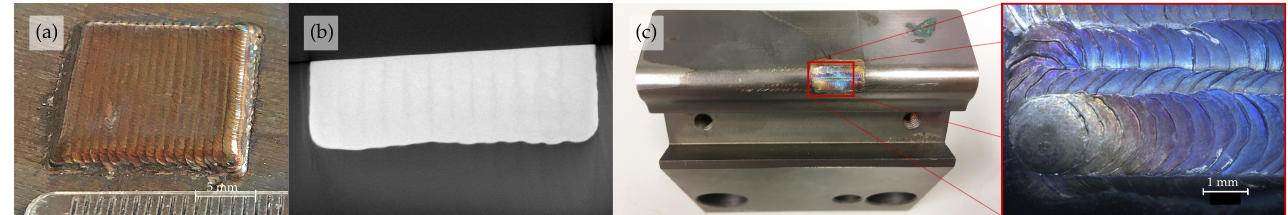
Figure 8. ( a ) 10-layer deposition welding with inductive preheating. ( b ) CT scan of the cut specimen. ( c ) Real forming tool repaired aided by inductive